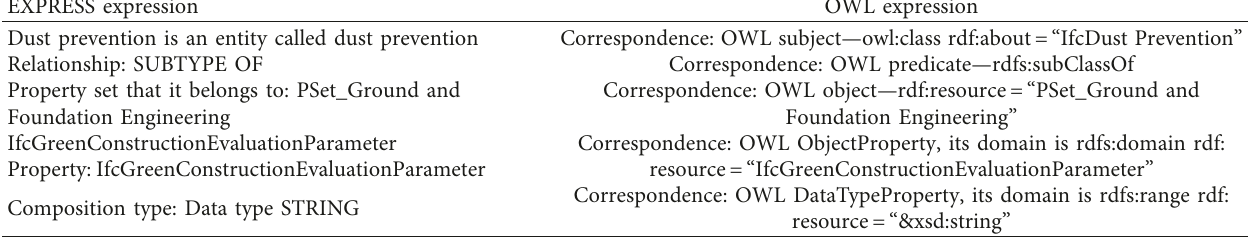
Table 4: EXPRESS-OWL mapping of dust control